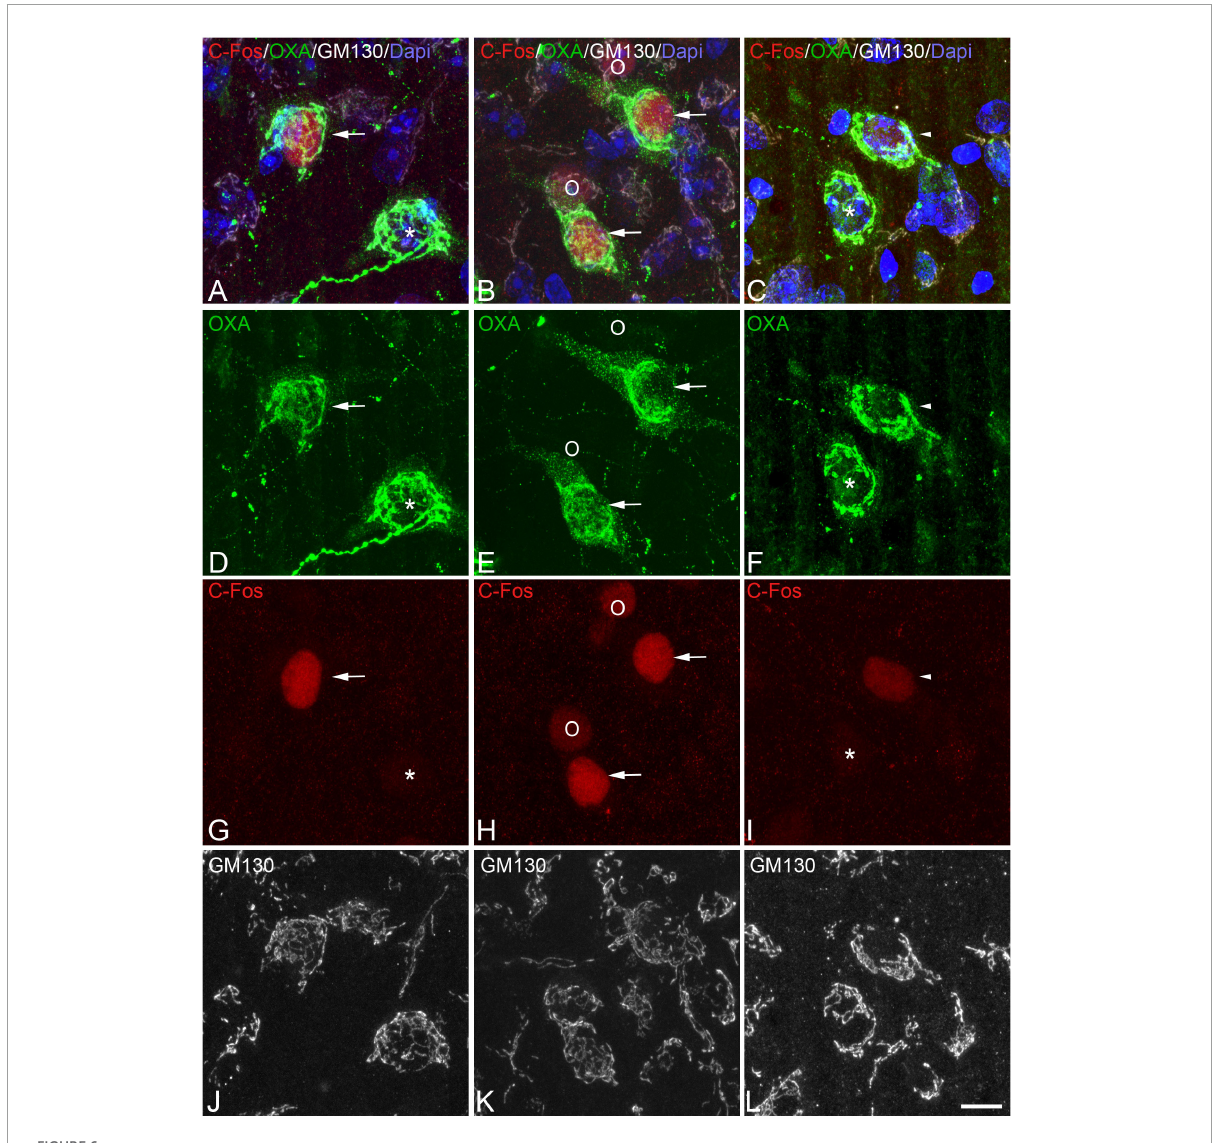
FIGURE6 (A-D-G-J, B-E-H-K, C-F-I-L) Groups of confocal projection images taken from OXA/C-Fos/GM130 triple-immunostained sections and counterstained with DAPI, showing examples of LH orexinergic neurons, from Syrian hamsters at arousal, with different patterns of immunostaining. Note the presence of orexinergic neurons with intense OXA immunostaining showing intense [solid arrows in panels (A,B,D,E,G,H) ] or moderate [solid arrowheads in panels (C,F,I) ] C-Fos expression—or with no C-Fos immunostaining [asterisks in panels (A,D,G,C,F,I) ]. The O symbols in panels (B,E,H) indicate examples of non-orexinergic neurons with moderate C-Fos expression. Also note both orexinergic and non-orexinergic LH neurons in hamsters at arousal showing patterns of the GA similar to those in euthermic animals. Scale bar shown in panel (L) indicates 10.5 µ